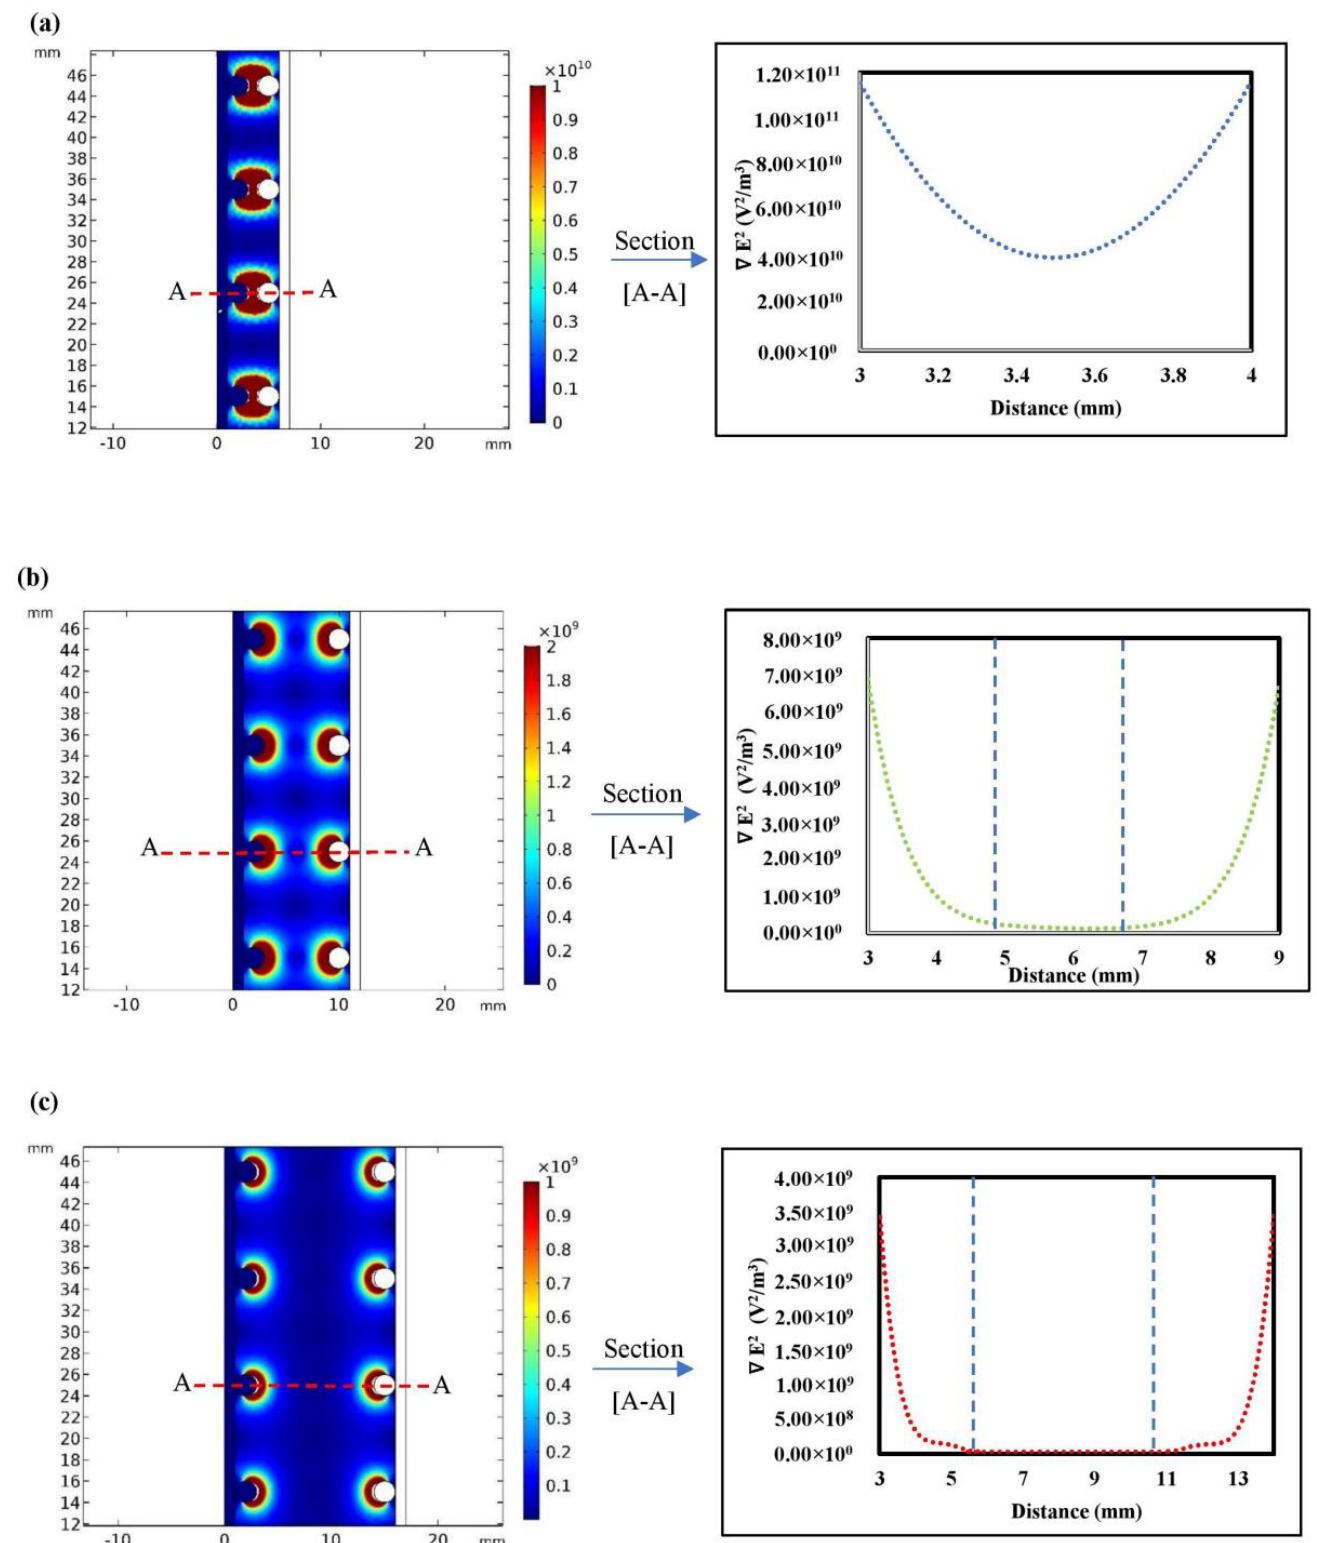
Figure 4. DEP force field ( ∇ |E| 2 ) using current of 600 mA and different electrodes spacings of ( a ) 0.5 cm, ( b ) 1 cm and ( c ) 1.5 cm.